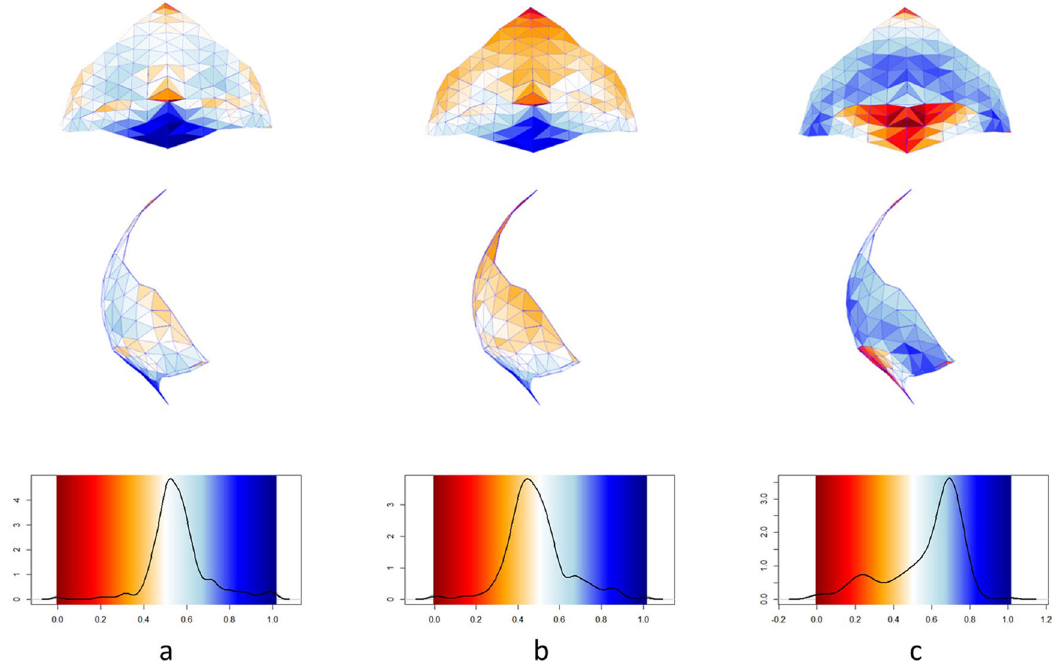
Fig. 4 Shape analysis of the occipital squama. 3D map variations of the occipital squama showing Altamura compared to the average morphology of Homo neanderthalensis ( a ), Mid-Pleistocene humans ( b ) and Homo sapiens ( c ). Colour maps are reported in posterior and lateral view. Warm and cold colours indicate respectively which regions in the three average morphologies are respectively locally contracted and expanded compared to